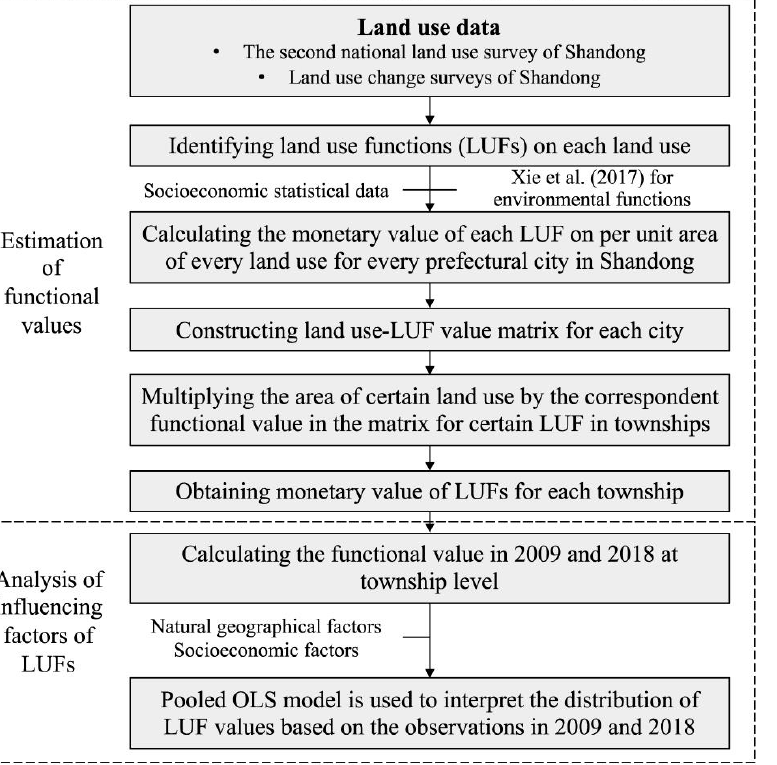
Figure 3. Flowchart of the